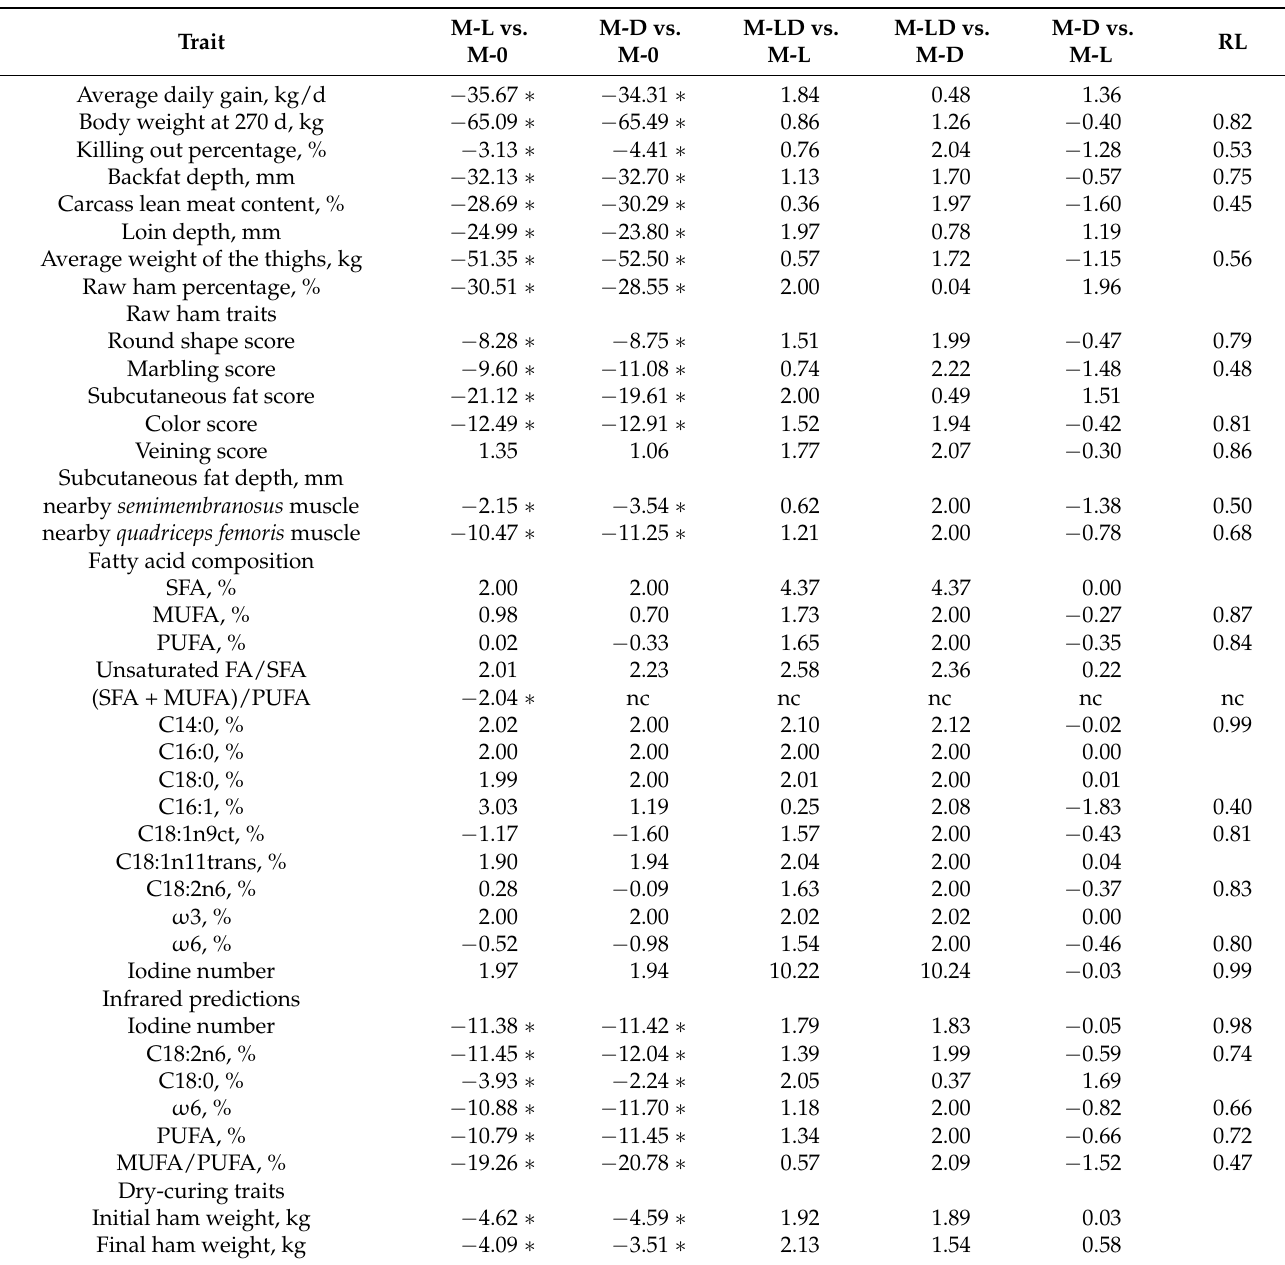
Table 5. Differences in Akaike information criterion (AIC) of models and relative likelihood (RL) of Model M-L with respect to Model M-D (for M-D models that were significantly different from M-0 and with AIC lower than that of the M-L model). Models are assumed to be significantly different (*) for differences in AIC < − 2 1,2